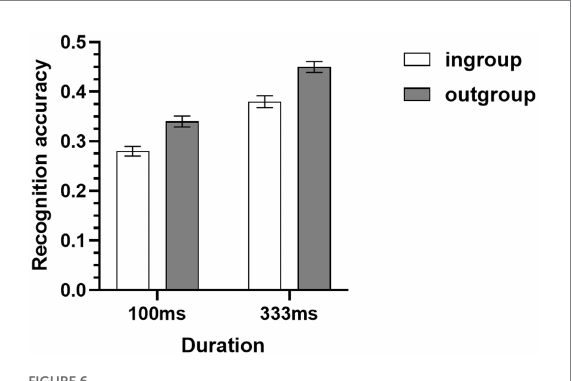
FIGURE 6 Mean recognition accuracies of micro-expressions of ingroup and outgroup members in Study 2B. Error bars represent standard